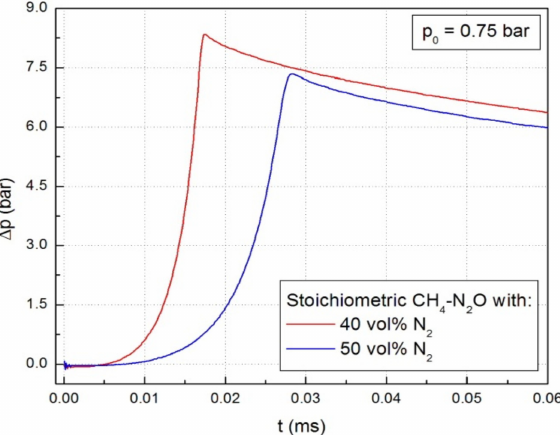
Figure 2. Pressure variation during explosions in stoichiometric CH 4 -N 2 O mixture diluted with various N 2 amounts, at p 0 = 0.75 bar and room